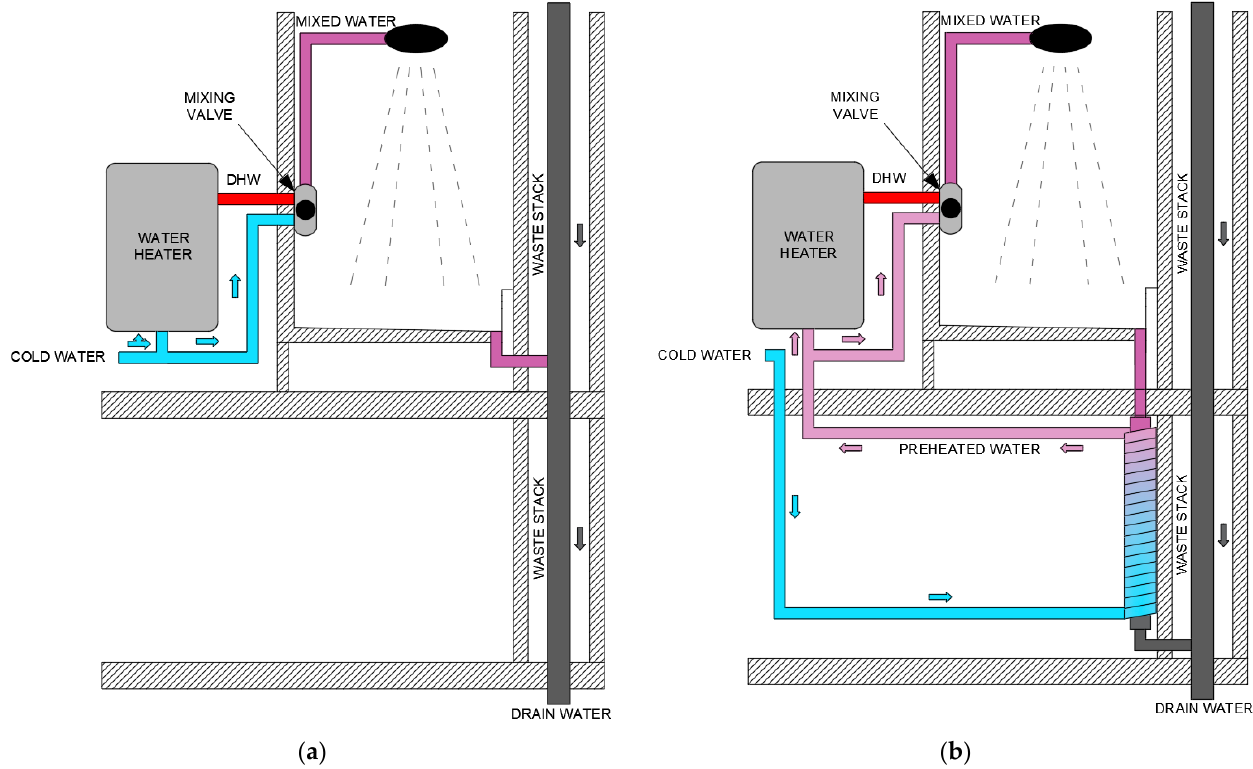
Figure 4. Installation example of a vertical heat exchanger: ( a ) Installation without a shower heat exchanger; ( b ) Installation with a shower heat exchanger (DHW—domestic hot water).